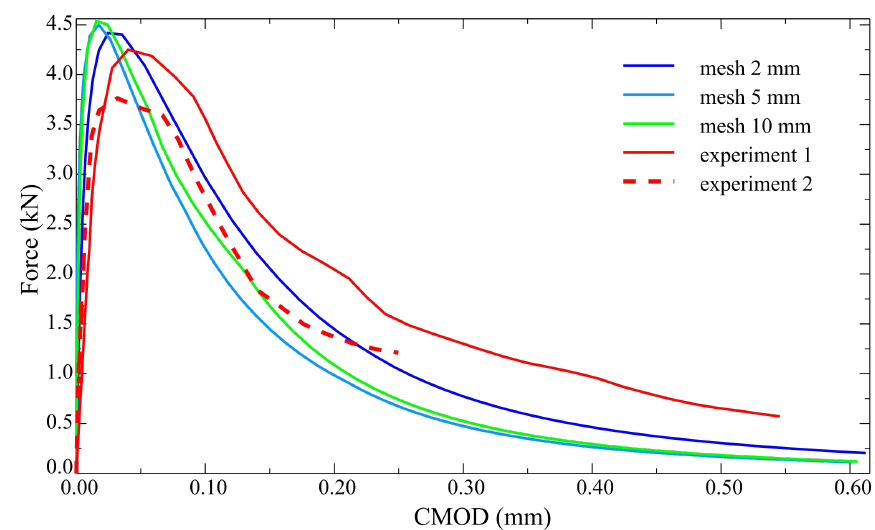
Figure 11. The plot of force vs. CMOD